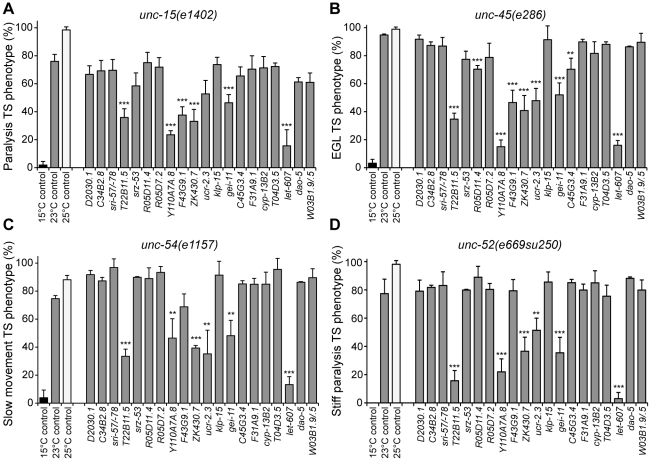
Aggregation modifiers that rescue the folding of endogenous TS mutant proteins.Modifiers of aggregation and toxicity were tested on endogenous muscle TS mutant proteins. 15°C is the permissive temperature, 25°C is the restrictive temperature and 23°C is the temperature used for RNAi. Misfolding of TS mutant proteins was assessed by measuring the % of animals displaying the associated muscle dysfunction phenotype: (A) unc-15(e1402) (paramyosin), uncoordinated/slow movement; (B) unc-45(e286) (myosin assembly protein), egg laying and paralysis defect; (C) unc-54(e1157) (myosin), slow movement/paralysis; (D) unc-52(e669su250) (perlecan), stiff paralysis (±SD, n>3, Student t-test relative to 23°C control **p<0.01, ***p<0.001). Statistical comparison using 1-way ANOVA ***p<0.001.